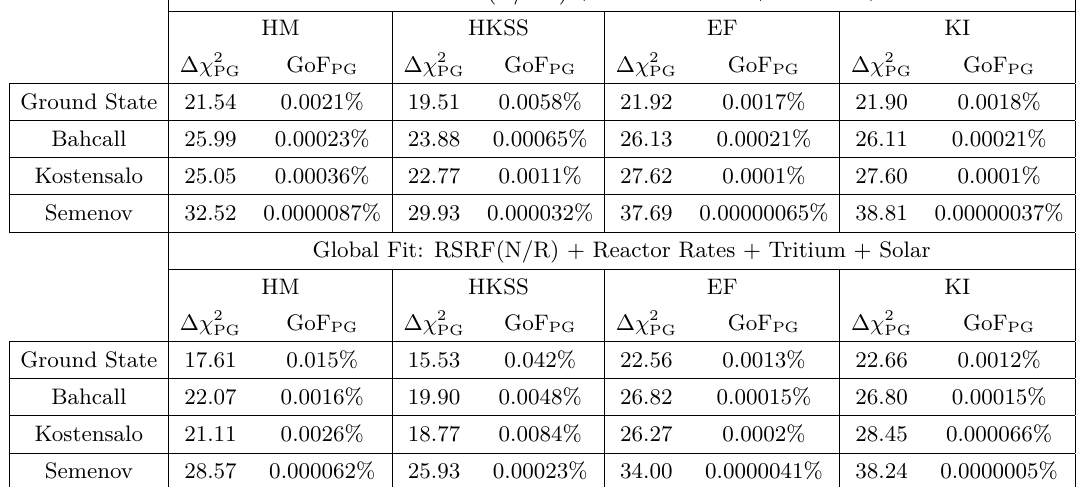
Table 8. χ 2 difference ∆ χ 2 of the parameter goodness of fit test [36] applied to the comparison of PG the neutrino oscillation fits of the reactor rates, spectral ratio data, tritium data, and solar bound with the Gallium data using the four Gallium detection cross sections in table 1. The values of the corresponding parameter goodness of fit GoF PG are calculated with two degrees of freedom corresponding to the two common oscillation parameters sin 2 2 ϑ ee and ∆ m 2 . The column titles 41 RSRF(N/DB) and RSRF(N/R) indicate, respectively, the combined fits of NEOS/Daya Bay and NEOS/RENO data with those of the other reactor spectral ratio experiments discussed in the text (DANSS, PROSPECT, STEREO, and Bugey-3). The column titles HM, HKSS, EF, and KI refer to the four reactor neutrino fluxes discussed in section